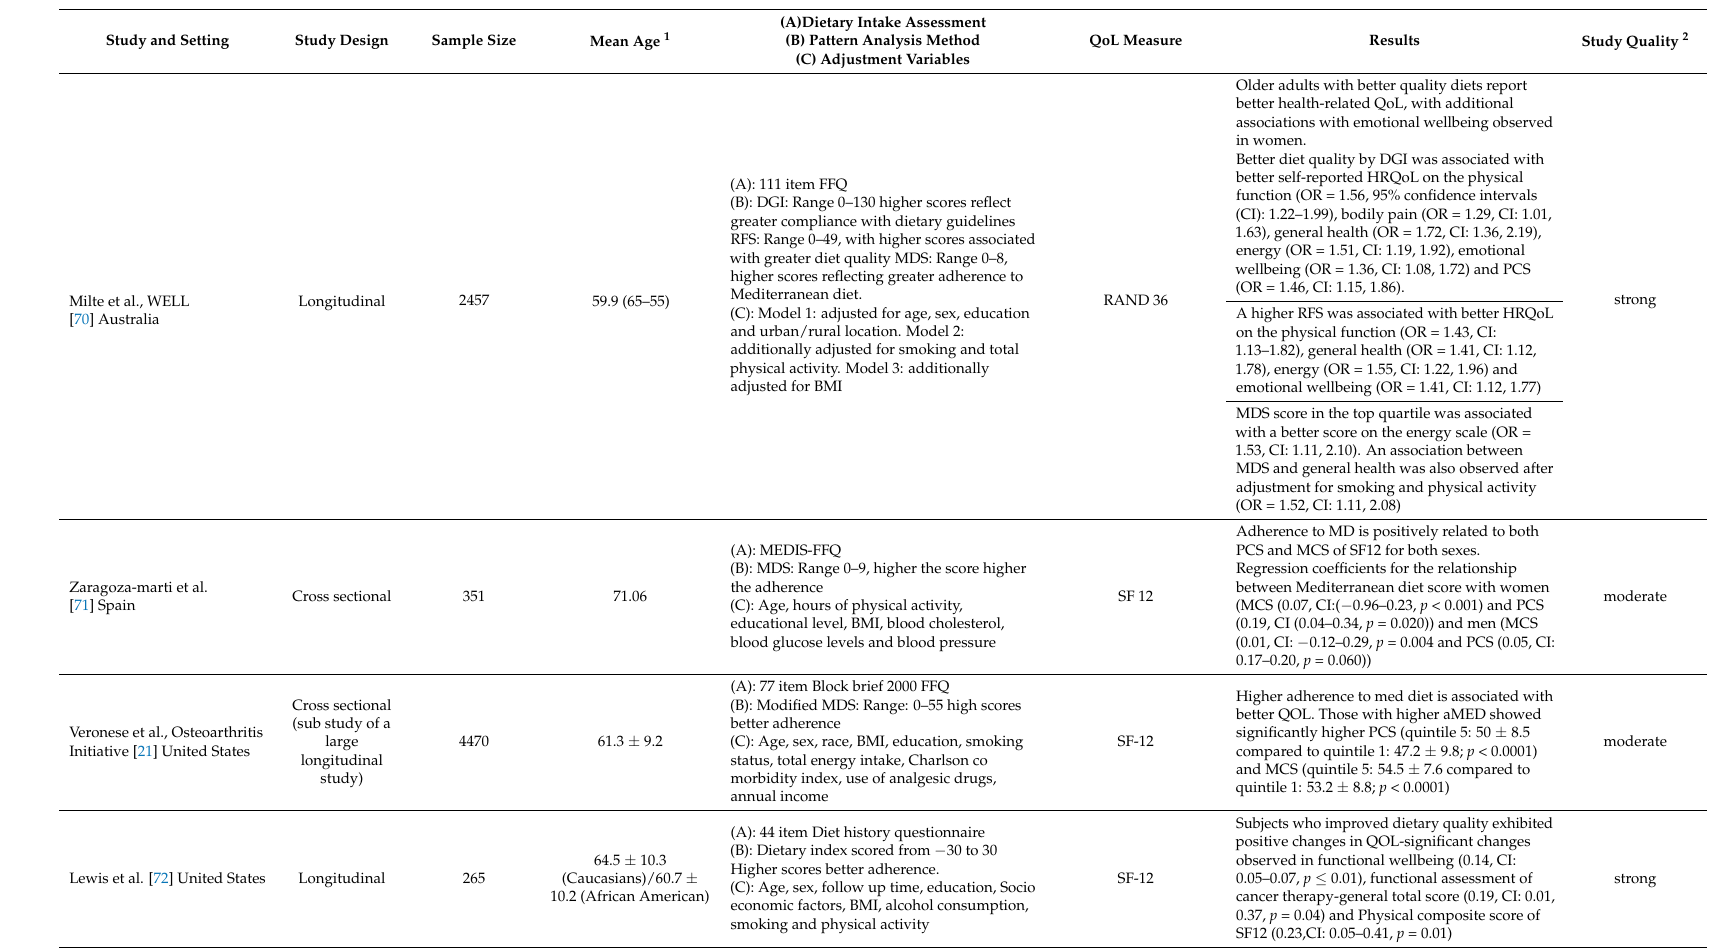
smoking and physical